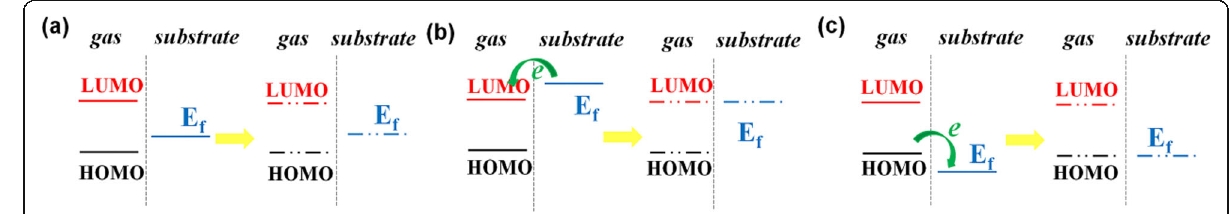
Fig. 3 Schematic diagram of the charge transfer